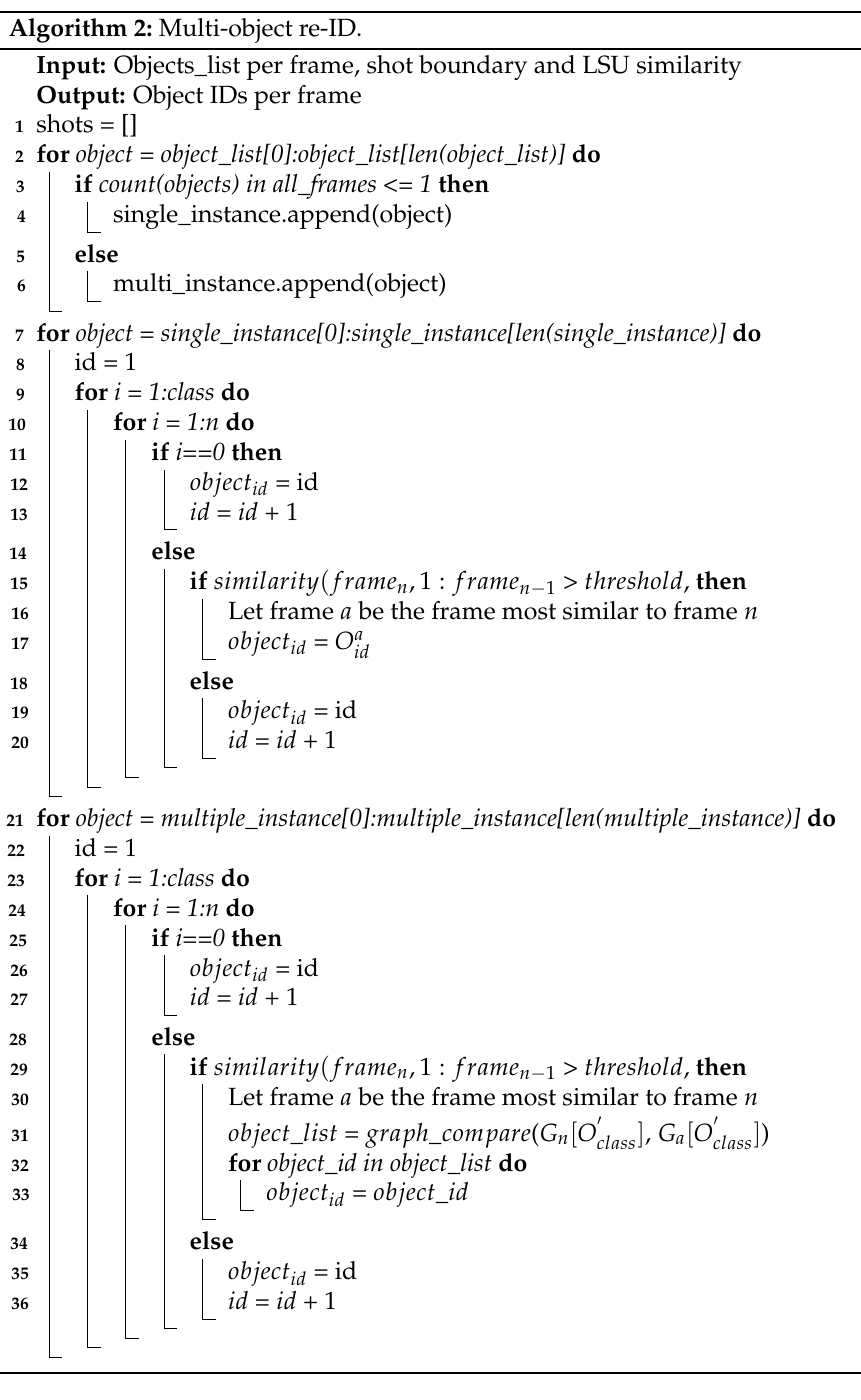
Algorithm 2: Multi-object